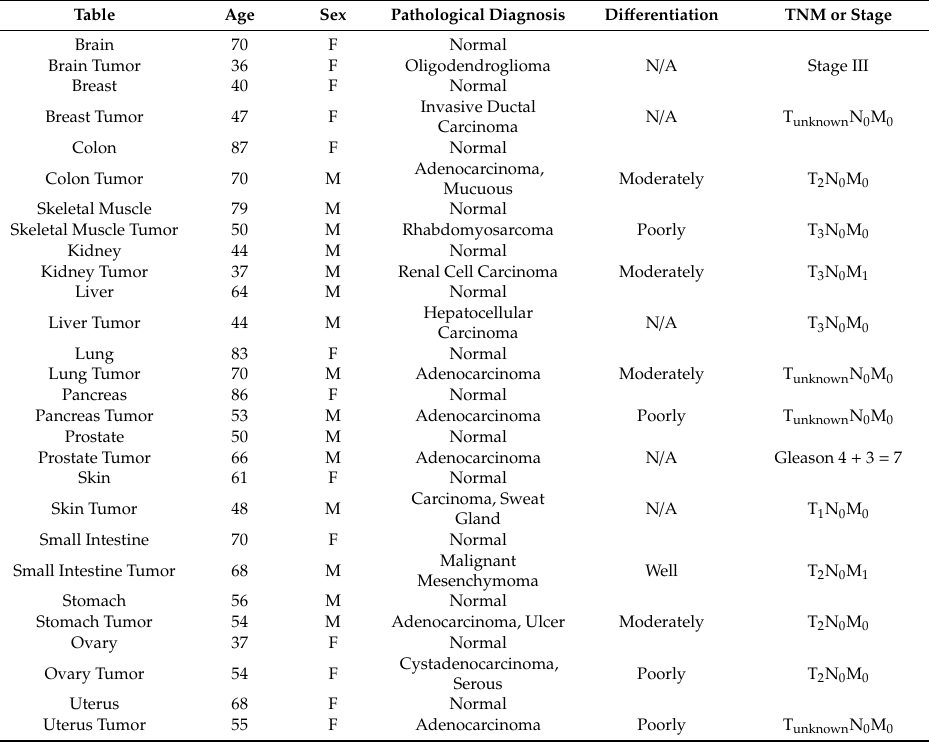
Table 1. Donor and patient information on the tissue array sections.